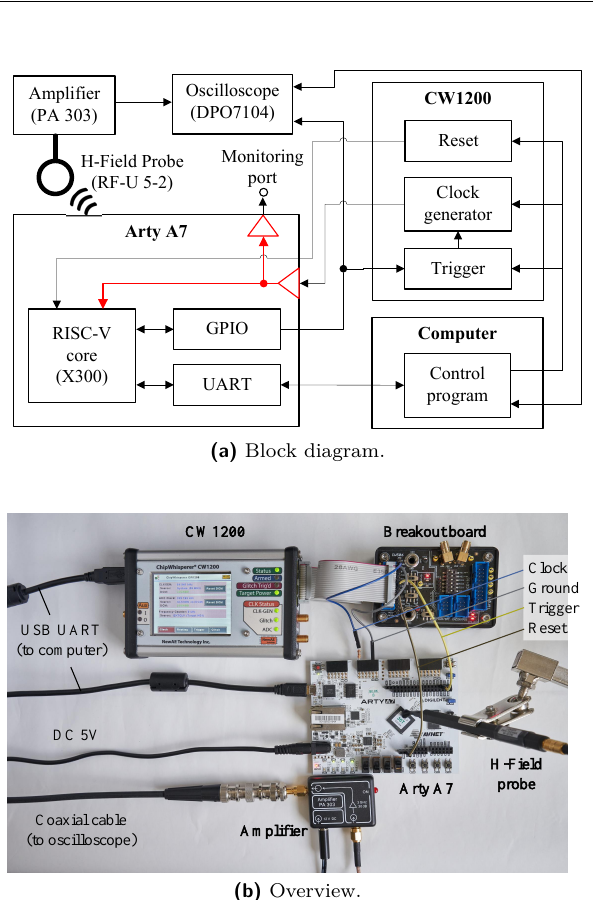
Figure 7: Experimental setup. Computer is connected to Arty A7 and CW1200 with USB, and Arty A7 and CW1200 are connected with wires. The clock signal wire is equipped with a resistor of 100 Ω for impedance matching, and the clock signal is provided to the RISC-V core via input buffer. The computer and oscilloscope are connected via Ethernet, and the EM wave is acquired via the oscilloscope using an H-field probe. Modifications from the original system-on-chip design are shown in red, that is, clock input/output ports.